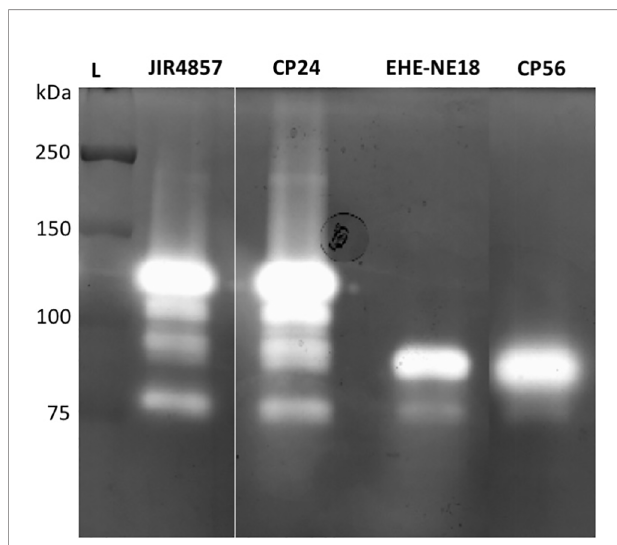
FIGURE 2 | Gelatinolytic activities expressed by different C. perfringens strains. Supernatant samples of 2 C. perfringens type A strains (JIR4857, CP24) and 2 C. perfringens type G strains (EHE-NE18, CP56) were analyzed for proteolytic activity by gelatin zymography. Lane L, Protein Ladder (Precision Plus Protein All Blue Pre-stained Protein Standards,